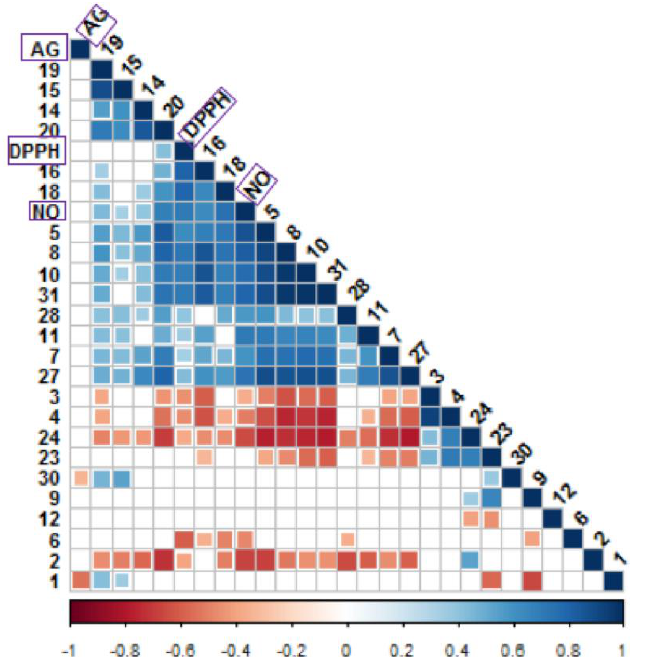
Figure 5. Correlogram visualizing correlation between metabolites analyzed using 1 H NMR and